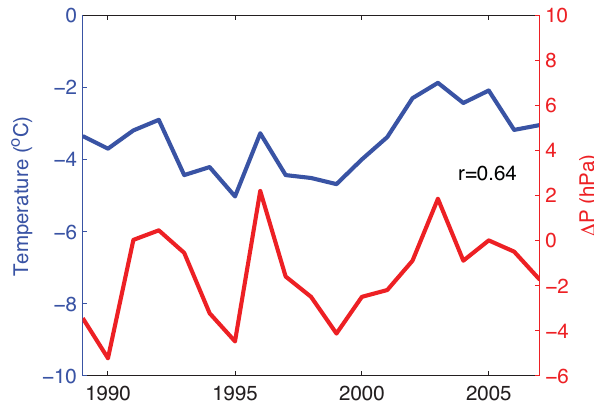
Fig. 4. Plot illustrating connection between mean annual air tem- perature measured in Aputiteq (blue) and 1 P (red), which is the mean winter (December–March) difference between atmospheric pressure measured in Stykkish ´ olmur (Iceland) and Tasiilaq (Green- land). See text for